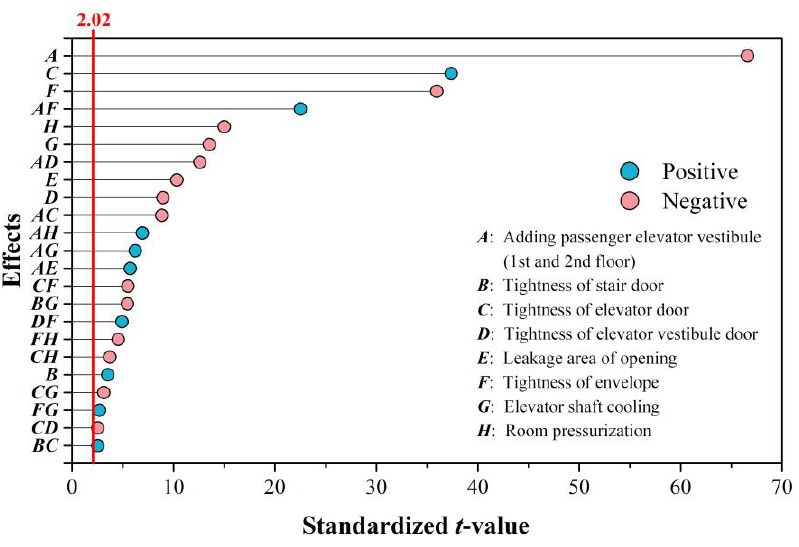
Figure 8. The maximum pressure difference at 1st floor elevator doors: Pareto effect plot.